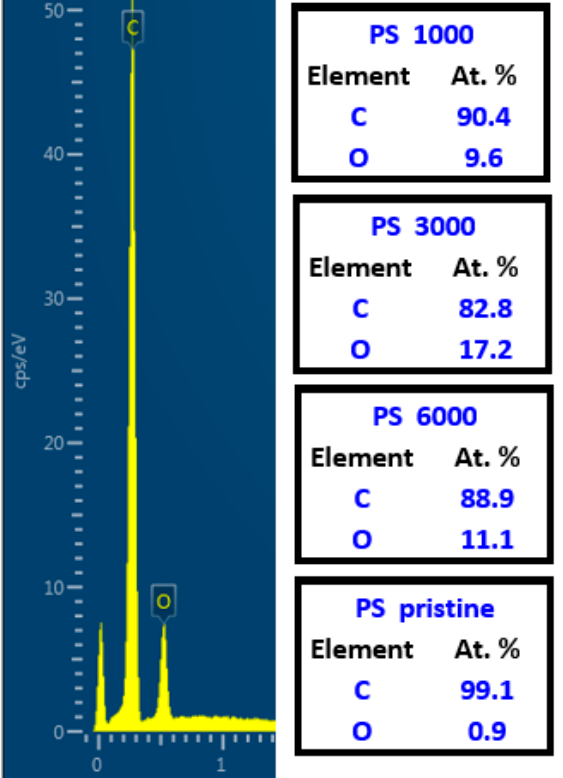
Figure 3. A spectrum from energy-dispersive X-ray spectroscopy (EDX) analysis and elemental atomic concentrations (carbon, oxygen) for PS samples treated by KrF laser with the laser fluence of 10 mJ · cm − 2 and 1000, 3000, and 6000 pulses.